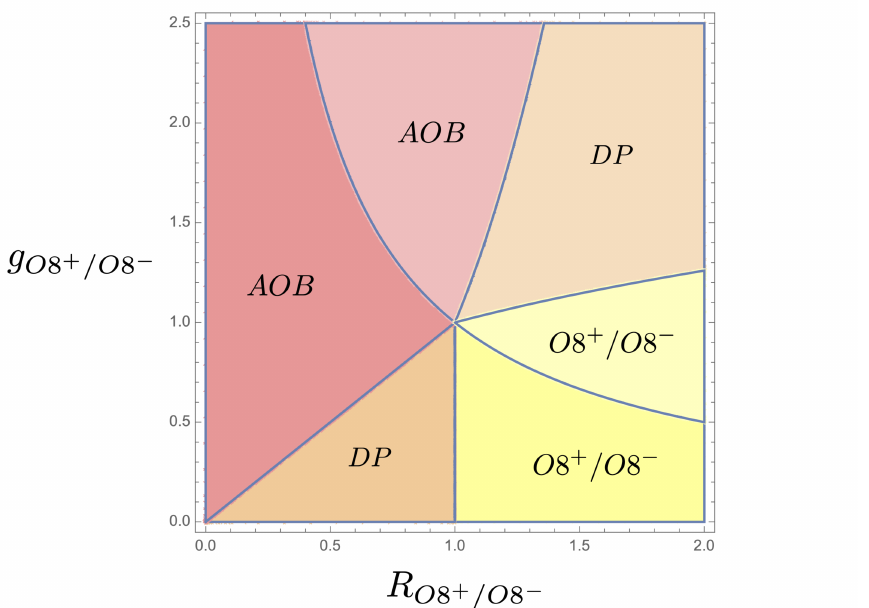
Figure 3 . Depiction of the moduli space of the rank 1 component of the nine-dimensional moduli space including the Dabholkar Park, AOB, and O 8 + /O 8 − compactifications. Following [32], from which this picture is taken, we take the O 8 + /O 8 − component as reference and parametrize the whole moduli space in terms of its coupling and distance between O-planes. For each value of these parameters the figure indicates which description is weakly coupled. The curved line running from top left to bottom right of the picture is a self-duality line, and points to both sides of the line are to be identified; this is also encoded in the color, where regions with different shades of the same color are to be